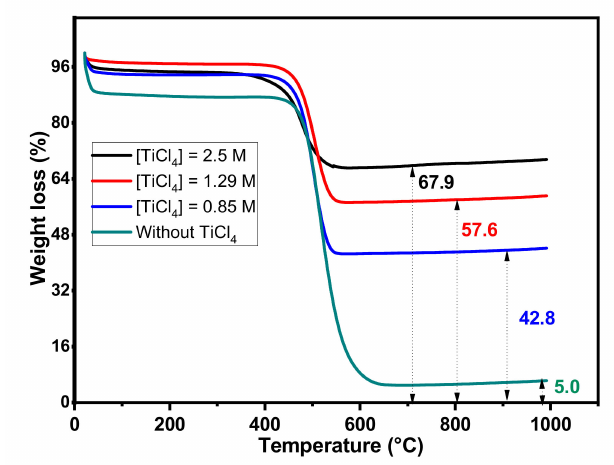
Figure 1. TGA profile of AC and AC/TiO 2 ball composites with different TiCl 4